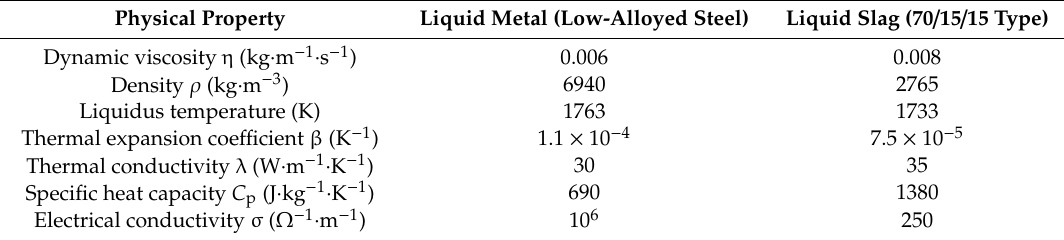
Table 3. Physical properties of the liquid metal and slag needed by the model, obtained